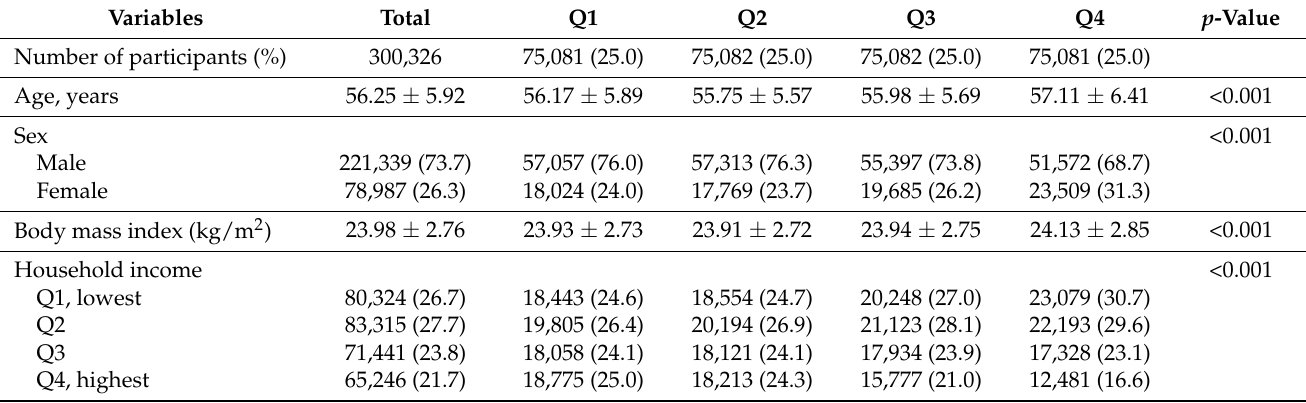
Table 1. Baseline characteristics of subjects according to the quartiles of total cholesterol